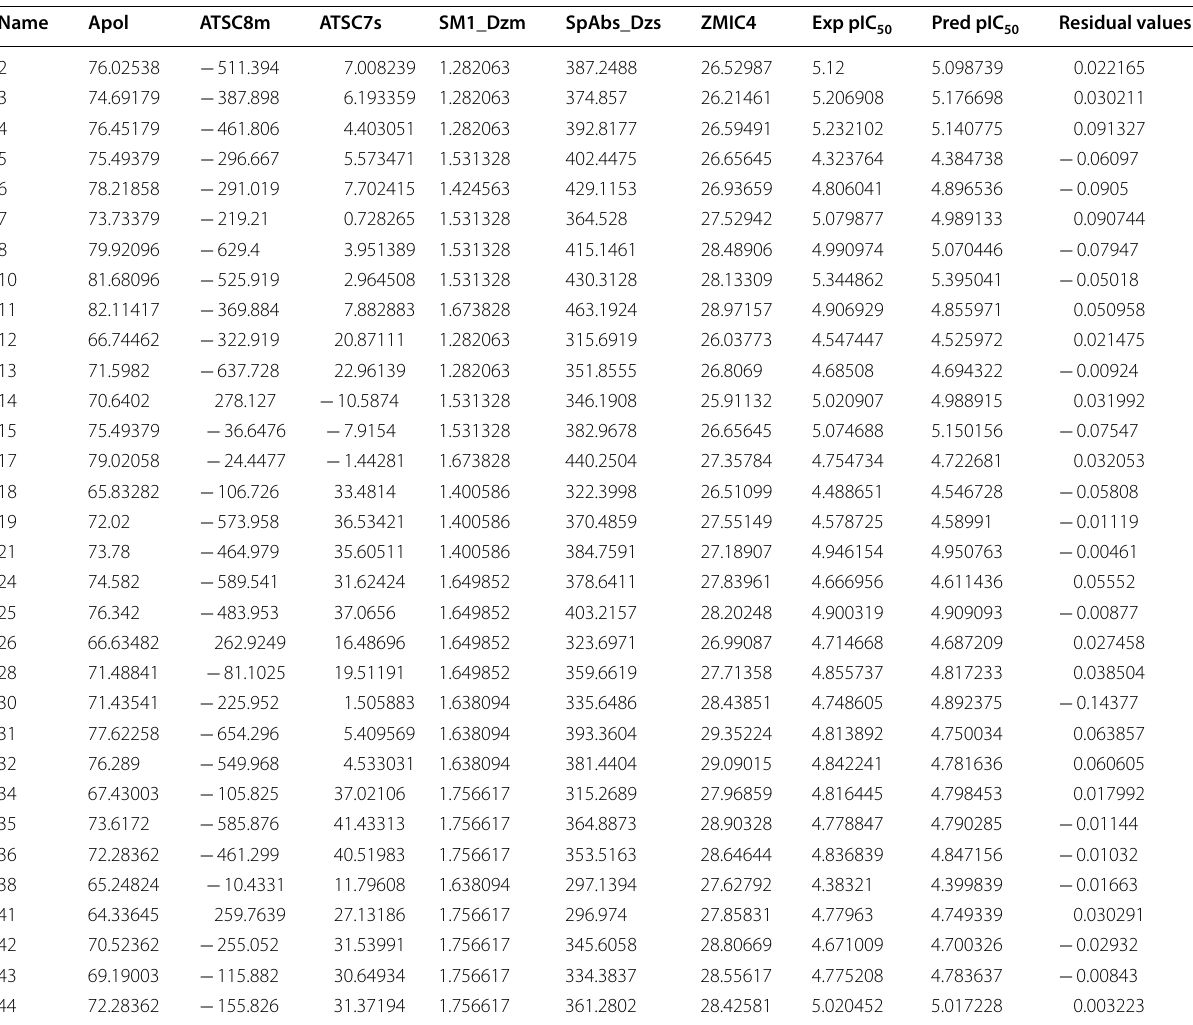
Table 3 Values of different types of molecular descriptors that have appeared in model 1, experimental and predicted pIC